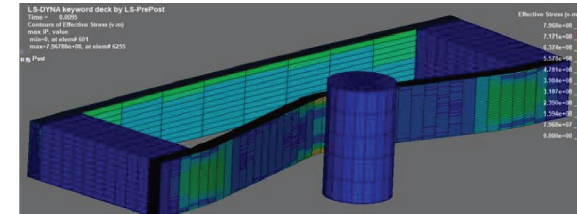
Figure 13: Von Mises stress.